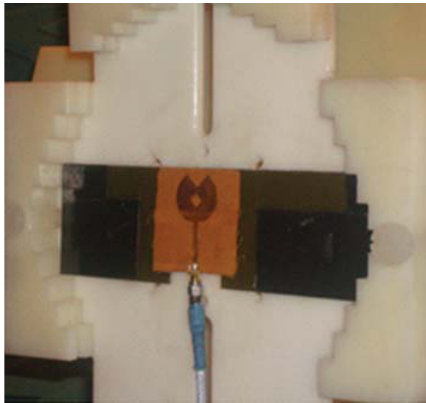
Figure 6: Snapshot of measured radiation pattern environment of the UWB textile antenna using copper conducting